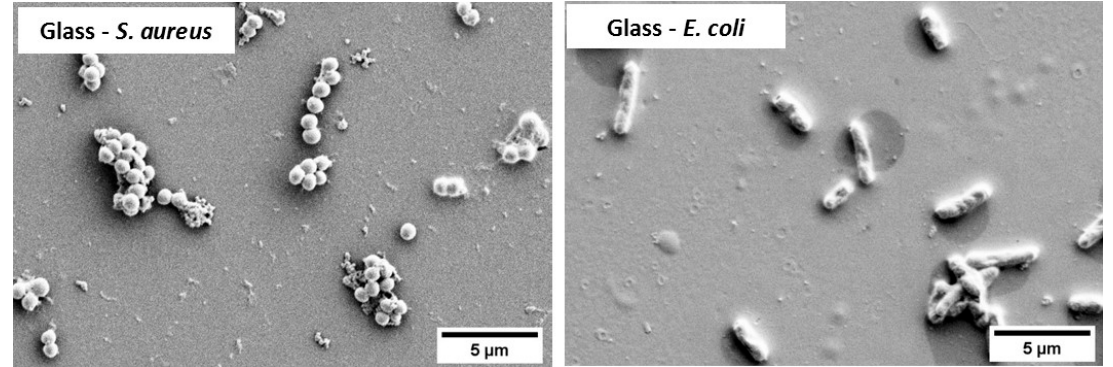
Figure 4. SEM images showing the morphology of S. aureus and E. coli bacterial cells attached to control glass samples after 15 min exposure.